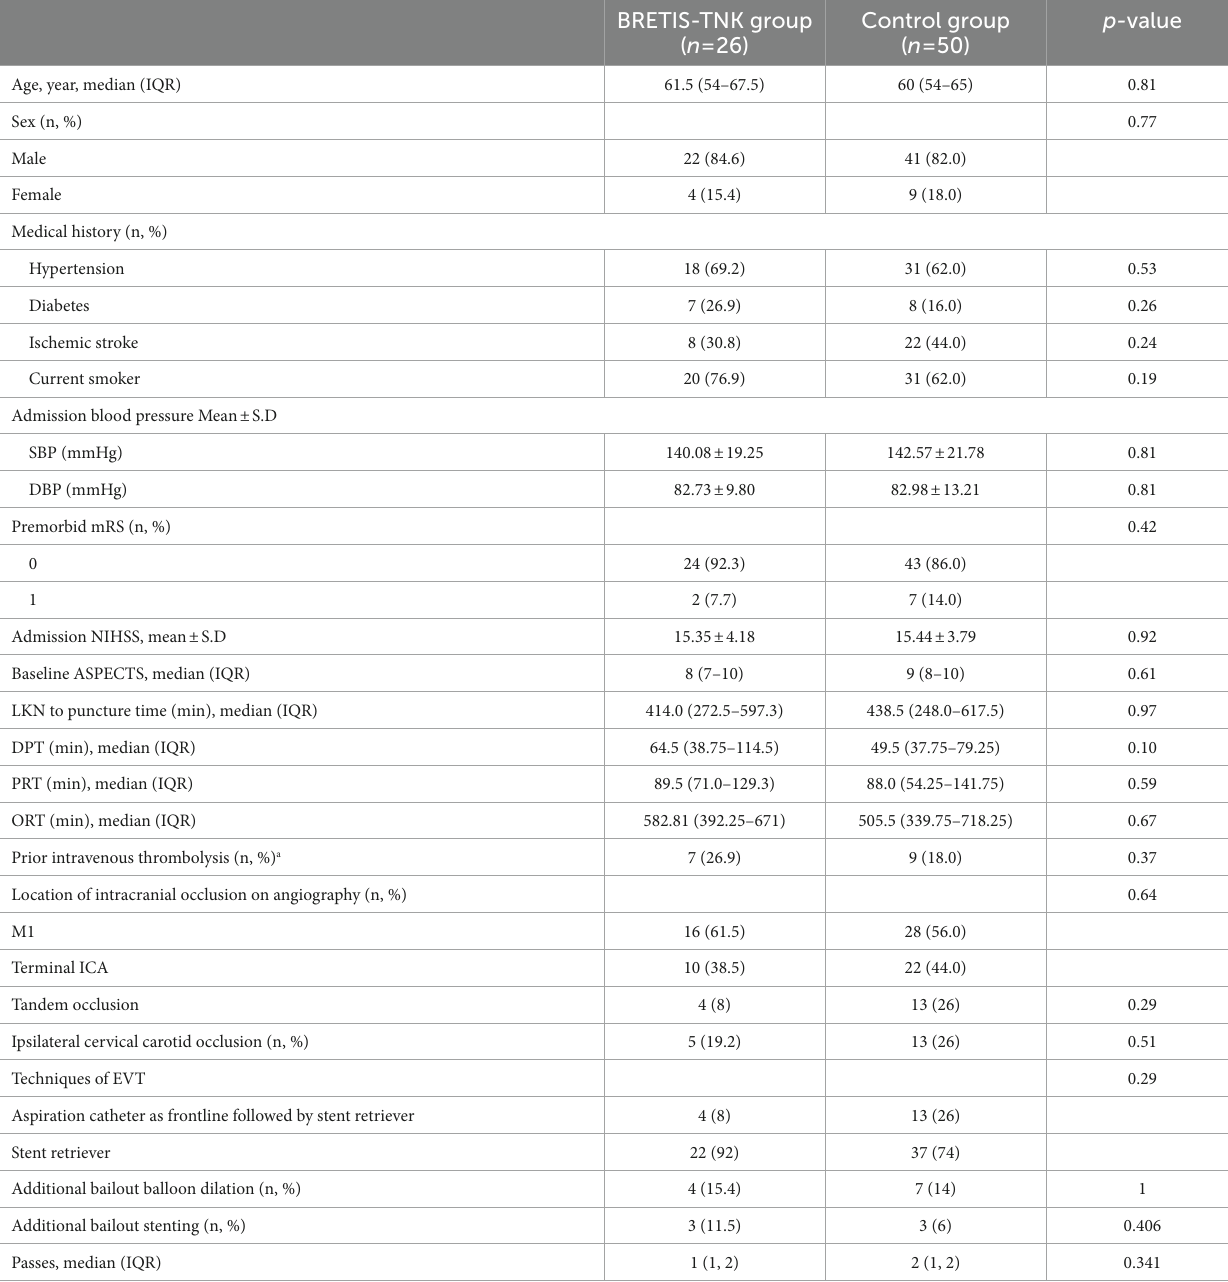
TABLE 1 Demographic and clinical